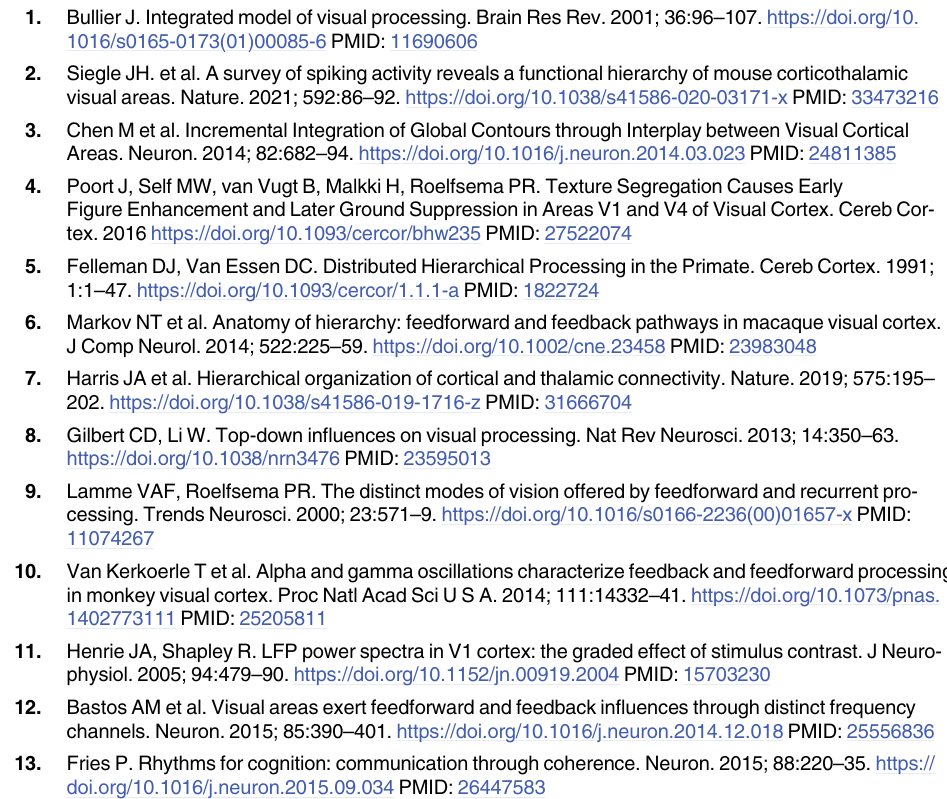
S2 Fig. Grand average bipolar LFPs for low contrast stimuli. Data for L1 to L6 in 6 visual areas. Underlying data: https://osf.io/pqf7z. LFP, local field